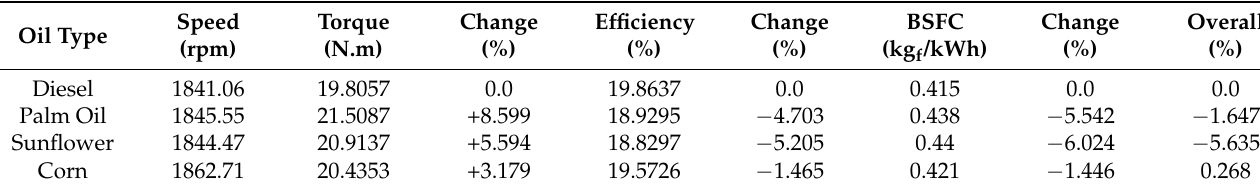
Table 12. Optimization-based RSM.